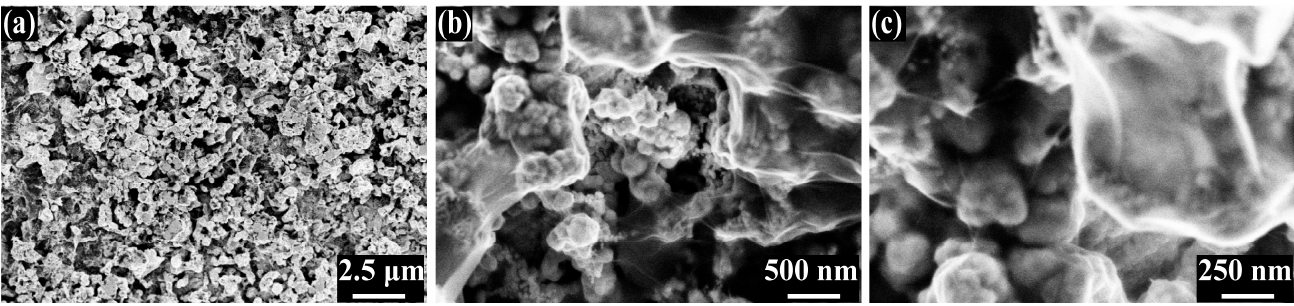
Figure 1. ( a ) The overall morphology of the electrochemically deposited rGO/AuNPs; ( b , c ) The mag- ni fi ed morphology of the outermost rGO/AuNPs.